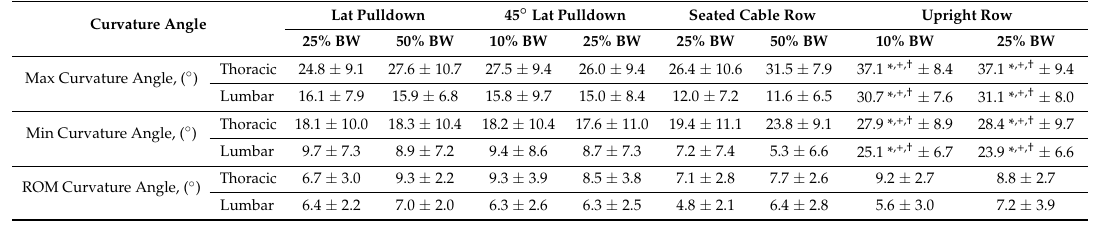
Table 1. Maximum, minimum and ROM of the curvature angles in the thoracic and lumbar regions, mean and standard deviation over all subjects.